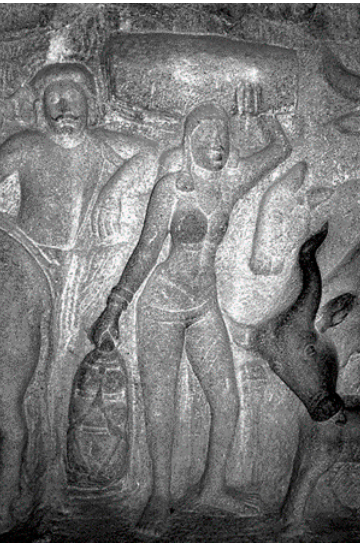
Figure 15. Detail of the Govardhanadhara Relief: Woman carrying u ṟ is, end of the sixth century. Rock- cut cliff. K ṛṣṇ a Ma ṇḍ apa, Mah ā balipuram, Tamil Nadu.